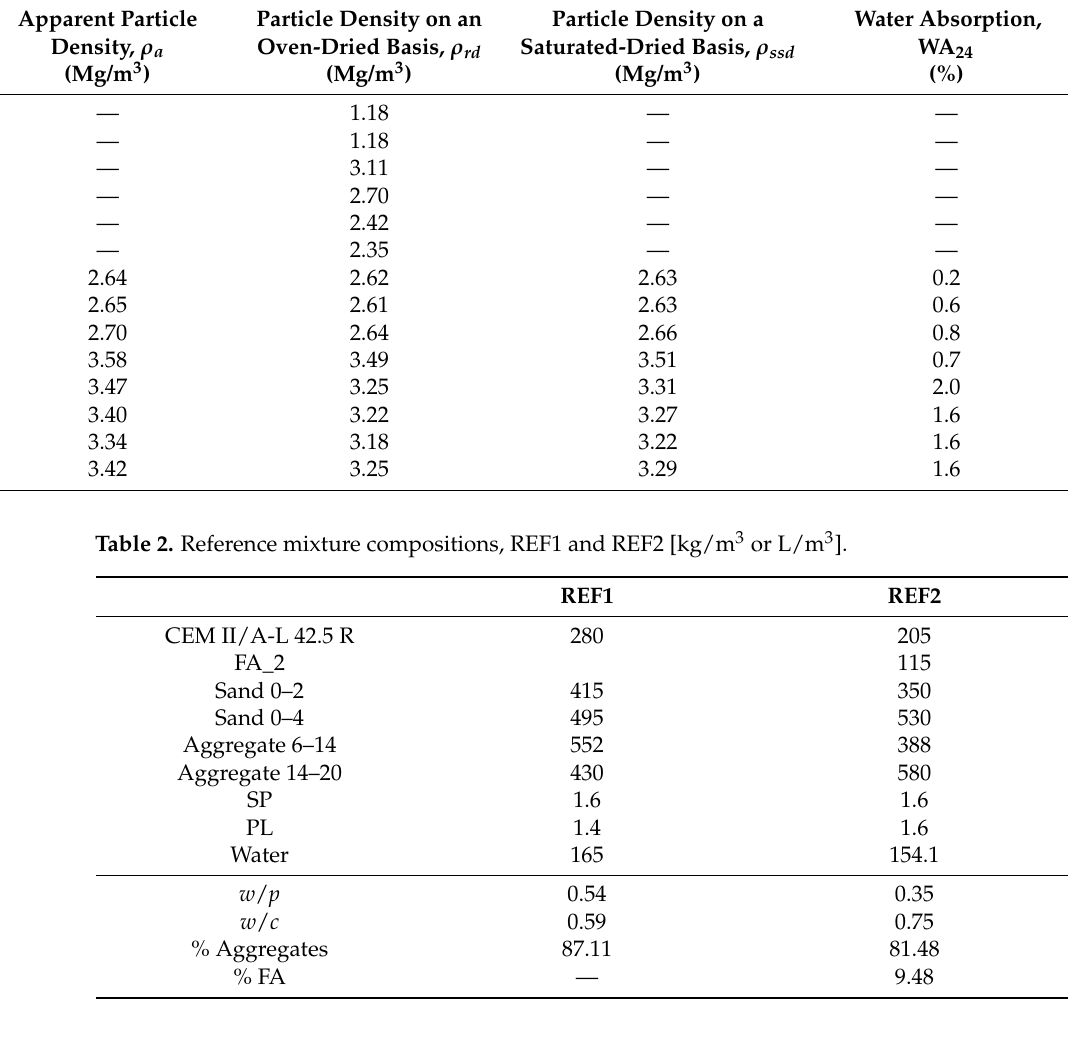
Table 1. Specific density of the natural and waste materials used in the concrete formulations.